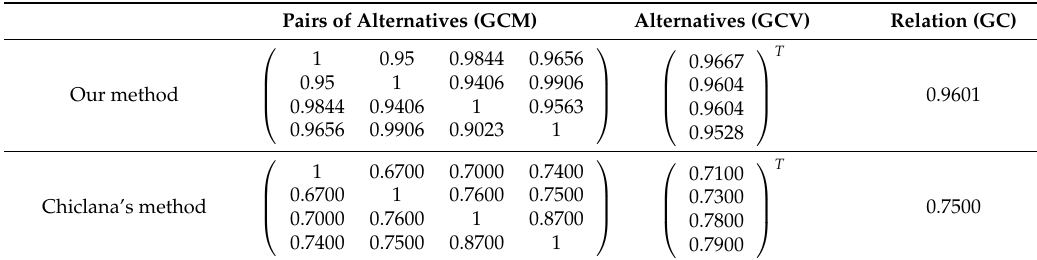
Table 2. The Consensus Measures of the Collective